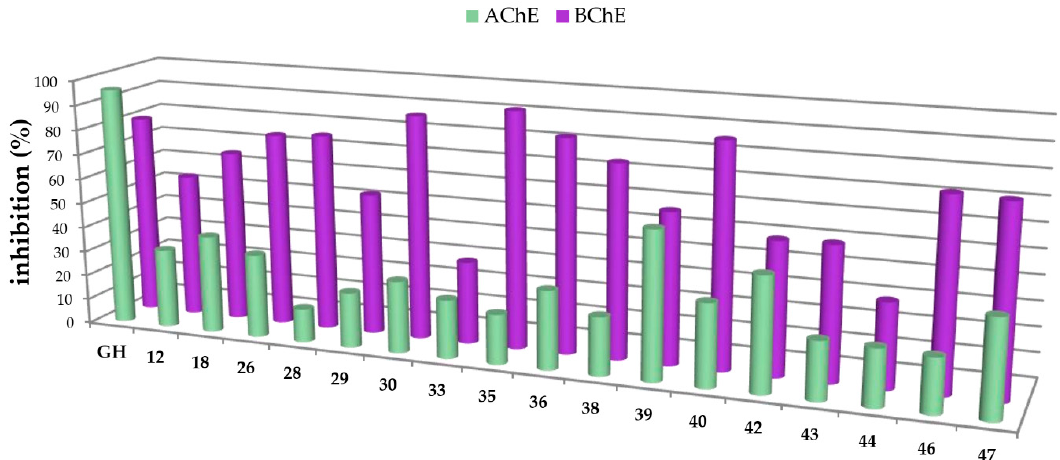
Figure 2. Percentage of inhibition of selected carboxamides and galantamine hydrobromide ( GH as standard), final concentration of the inhibitor 10 µM, determined by Ellman’s assay using acetylcholinesterase (green in the front) and butyrylcholinesterase (purple in the back).